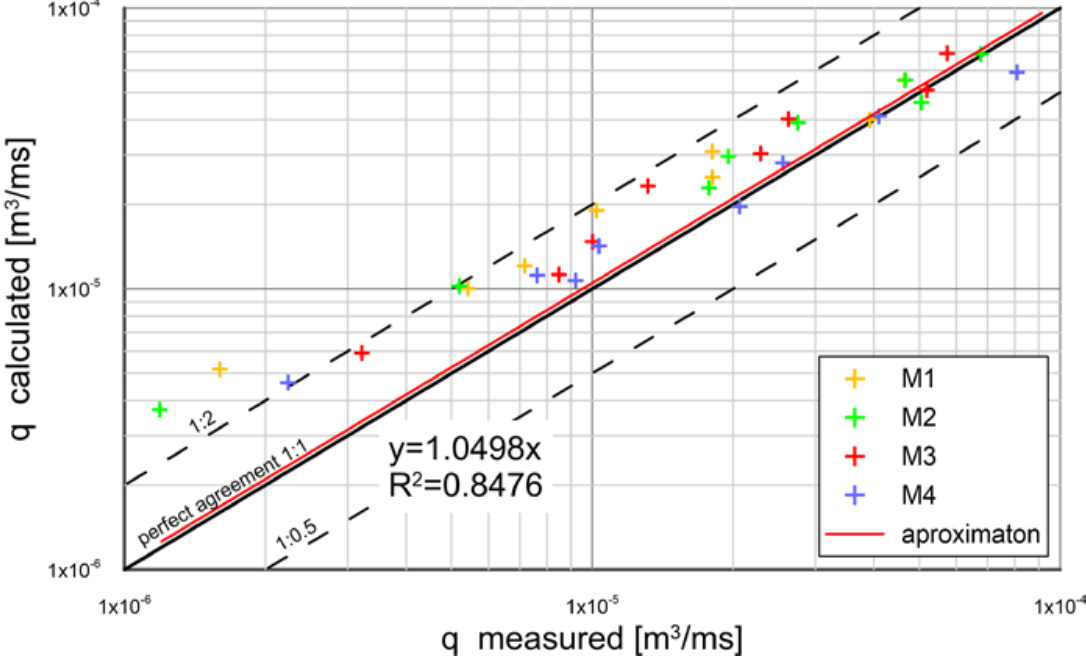
with a coeffi- 𝑦𝑦 = 𝑐𝑐𝑥𝑥